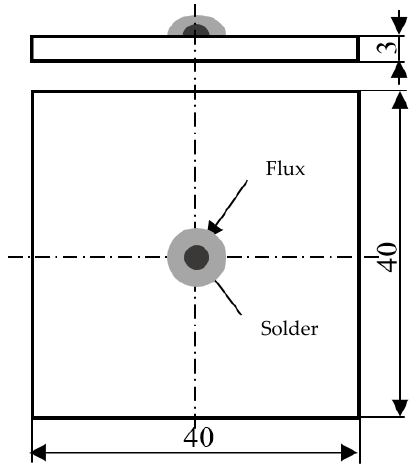
Figure 1. Schematic diagram of the spreading test.